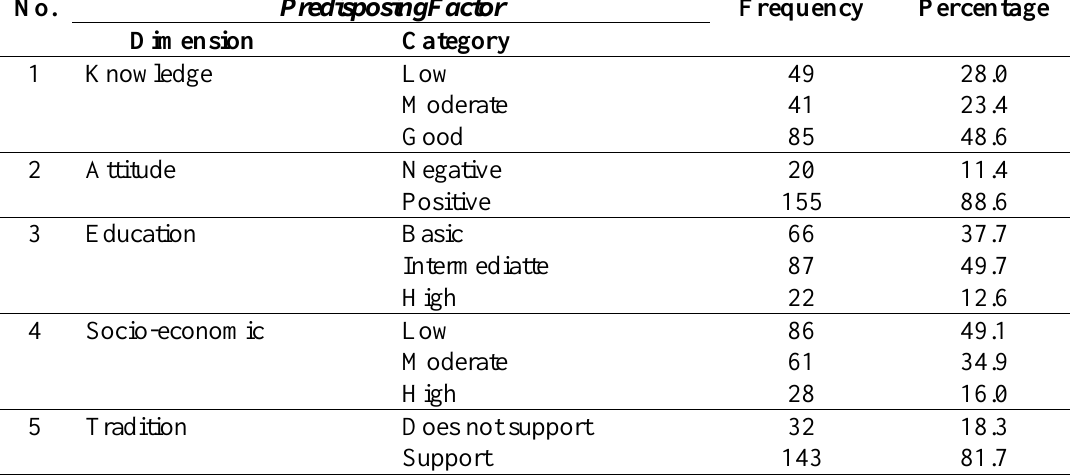
Table 1. Distribution Respondent based on Variable of Factor predisposing No.